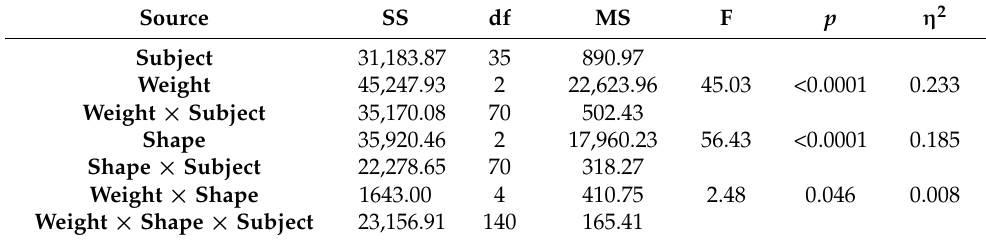
Table 5. Effects of object weight (volume) and shape on perceived weight.